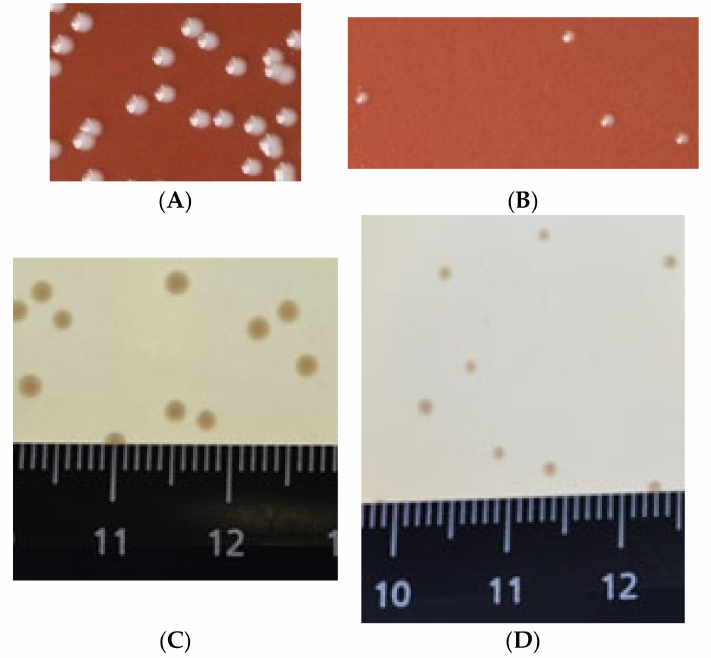
Figure 3. F. tularensis colonies morphology on chocolate agar ( A , B ), FT-agar ( C , D ): 15 NIIEG ( A , C ) and 15D ( B , D